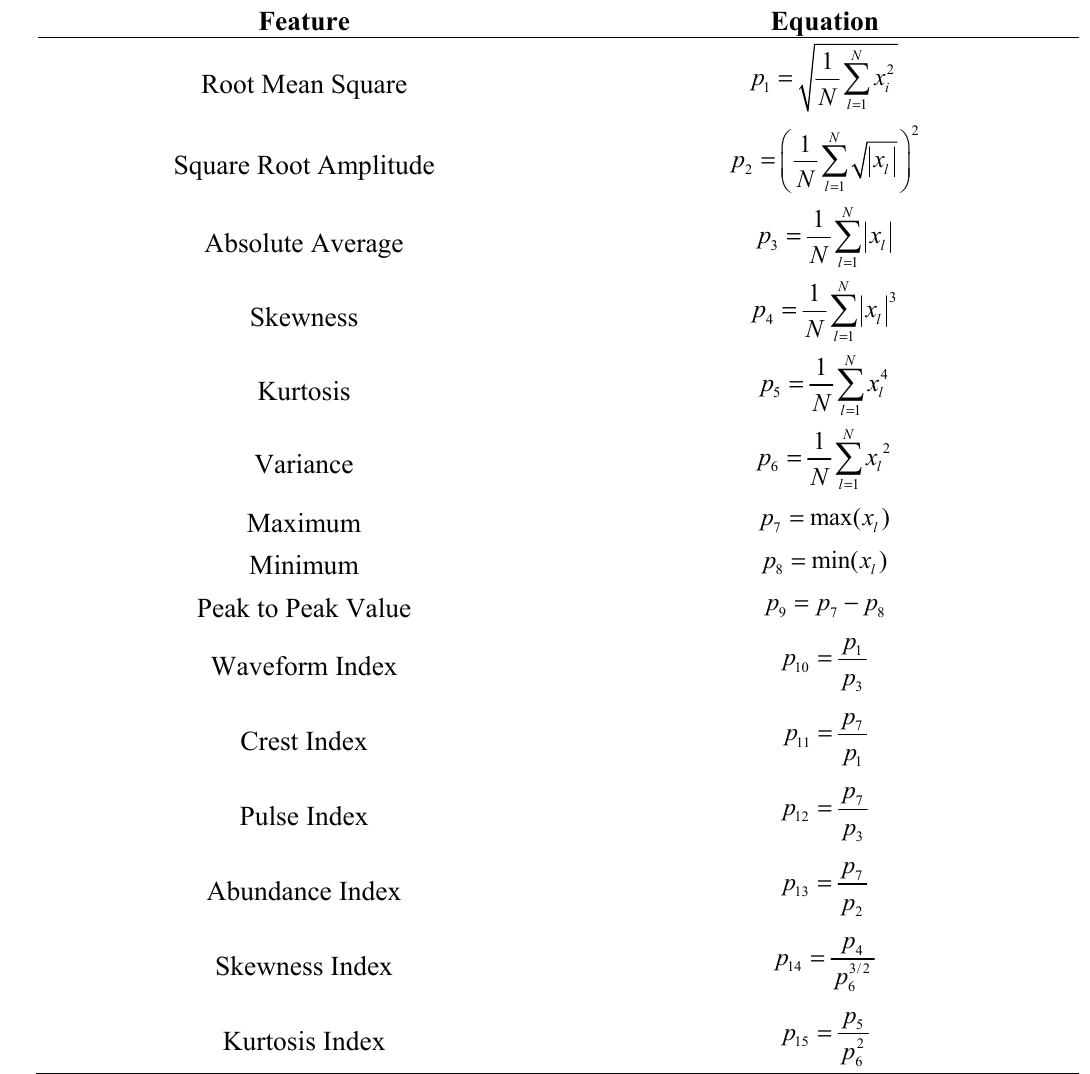
Table 2. The 15 time-domain